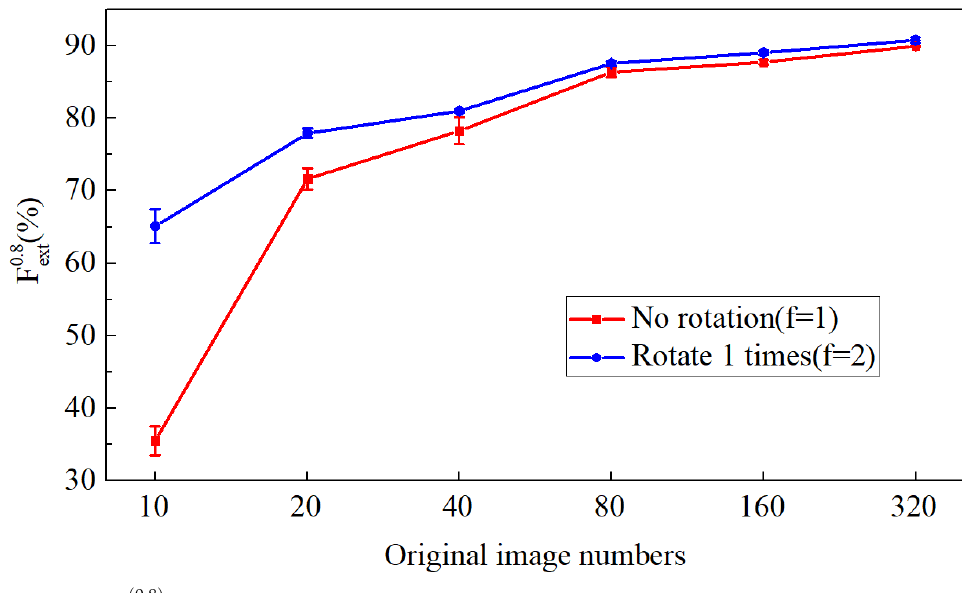
( 0.8 ) Figure 6. F of the models before and after rotation for di ff erent numbers of original images. ((cid:2868).(cid:2876)) ext Figure 6. 𝐹 of the models before and after rotation for different numbers of original images. (cid:3032)(cid:3051)(cid:3047)